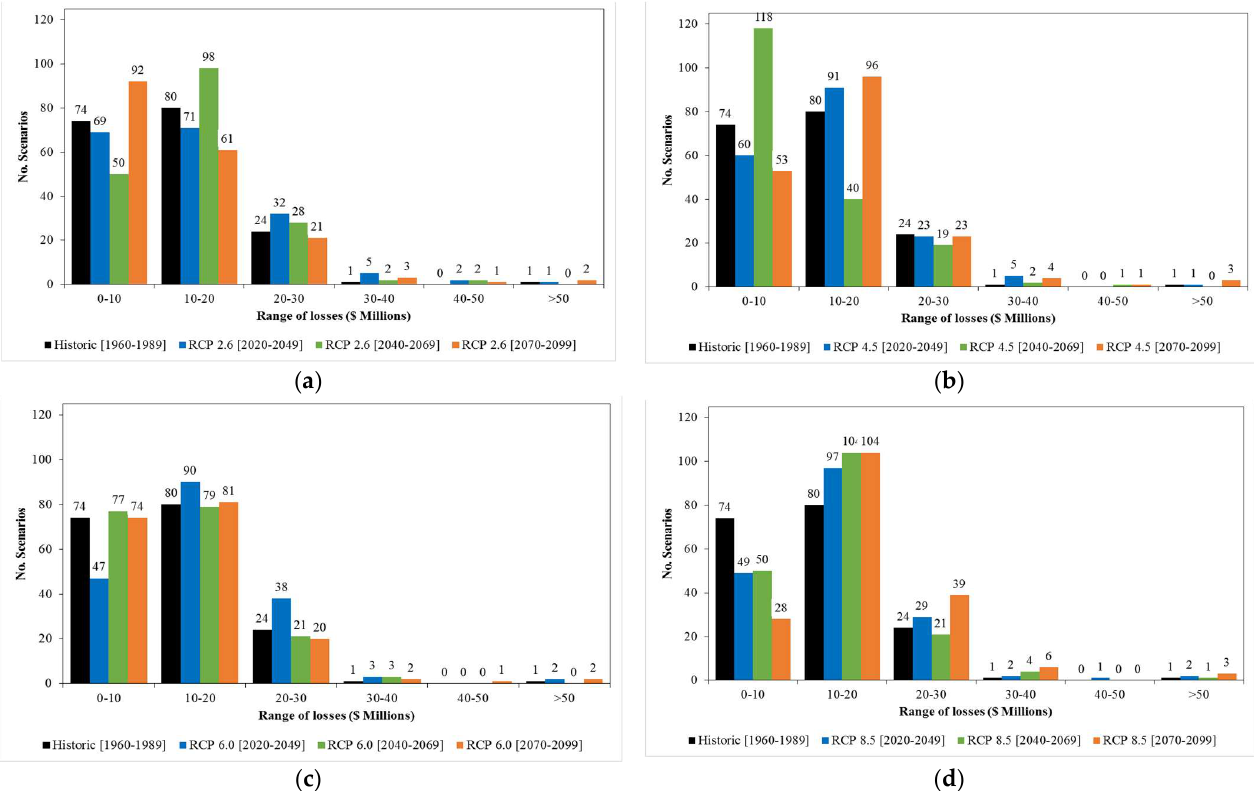
Figure 16. Histogram of economic expected losses for ( a ) RCP 2.6; ( b ) RCP 4.5; ( c ) RCP 6.0; ( d ) RCP 8.5.